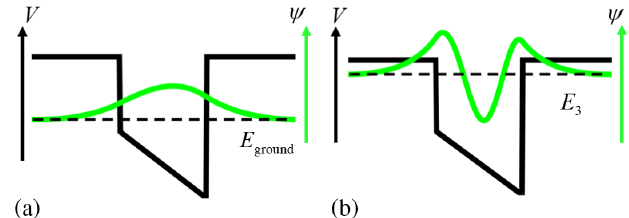
FIG. 2. Examples of acceptable answers to the question parts (a) and